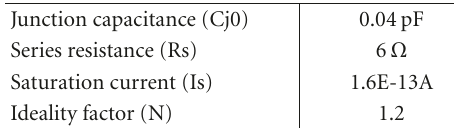
Figure 2: Filters S11 and S12 (dB).